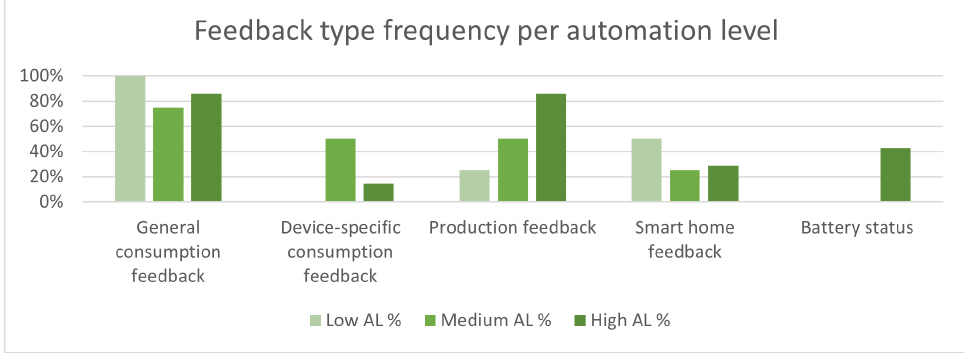
Figure 3. Feedback per automation